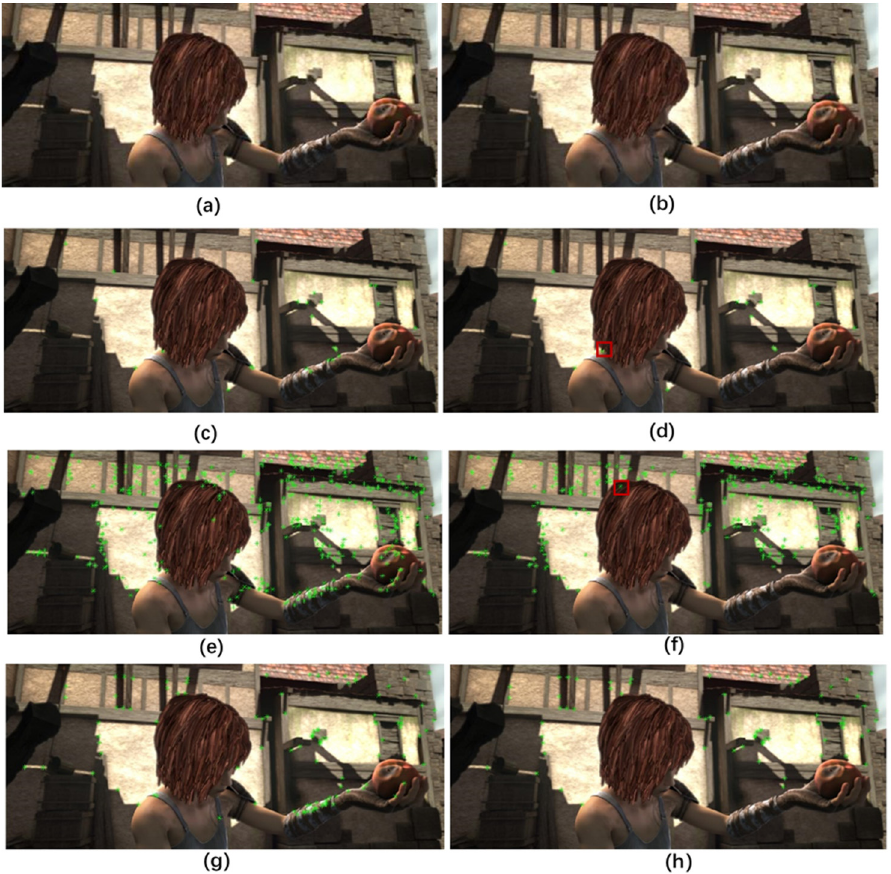
Figure 4. Comparison of different feature points extraction and their corresponding robust feature points results. ( a ) Current image, ( b ) next image, ( c ) FAST feature points, ( d ) robust and FAST feature points, ( e ) SURF feature points, ( f ) robust SURF feature points, ( g ) Harris feature points, and ( h ) robust Harris feature points. The green points in the figure are matching points, and the red dots in figures ( d , f ) are the error detection points